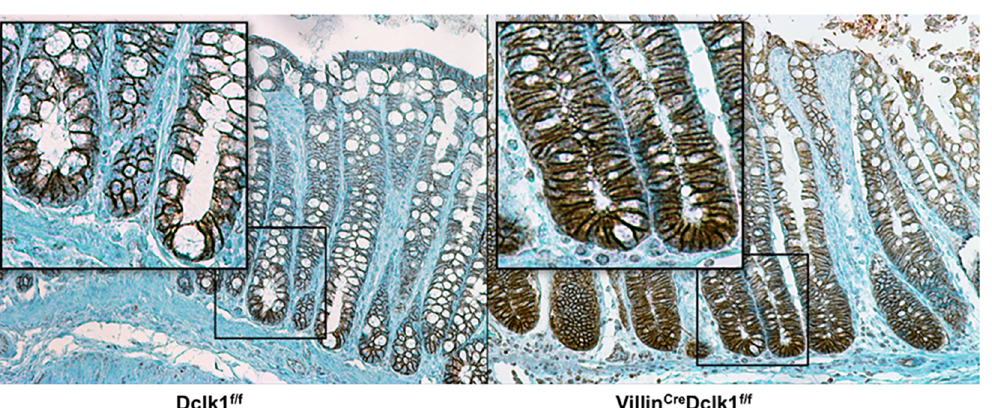
Fig 9. Immunohistochemical staining of β -Catenin in colon tissues following DSS treatment. The expression of β -Catenin (Brown) was identified by immunostaining with anti- β -Catenin antibody. Increased expression and increased nuclear localization of β -Catenin were found in Villin Cre ;Dclk1 f/f relative to Dclk1 f/f mice. Alcian blue was used for